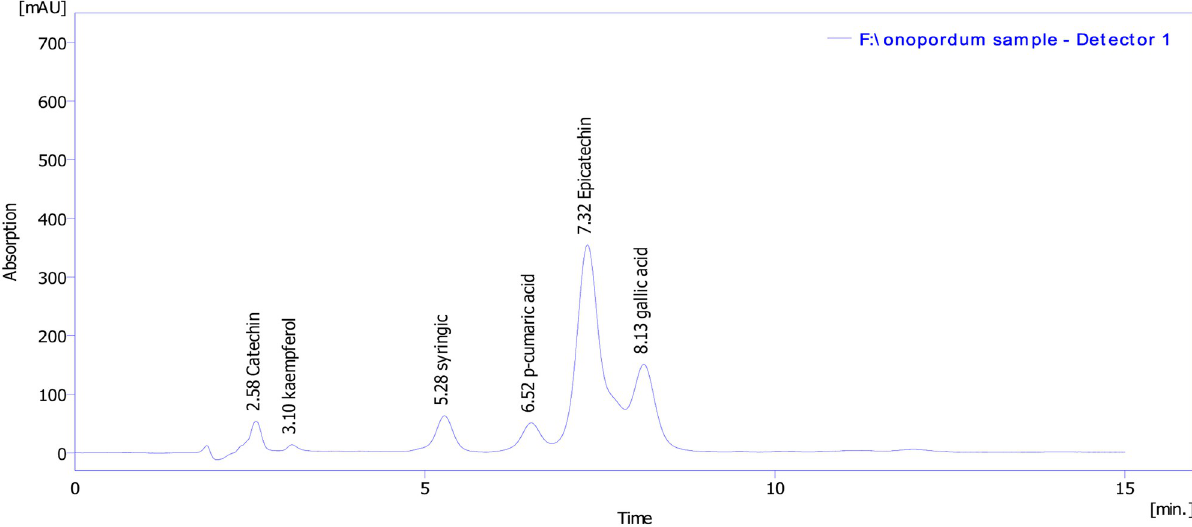
Fig 2. Chromatographic profiles of plant extract. https://doi.org/10.6084/m9.figshare.21828834.v1.